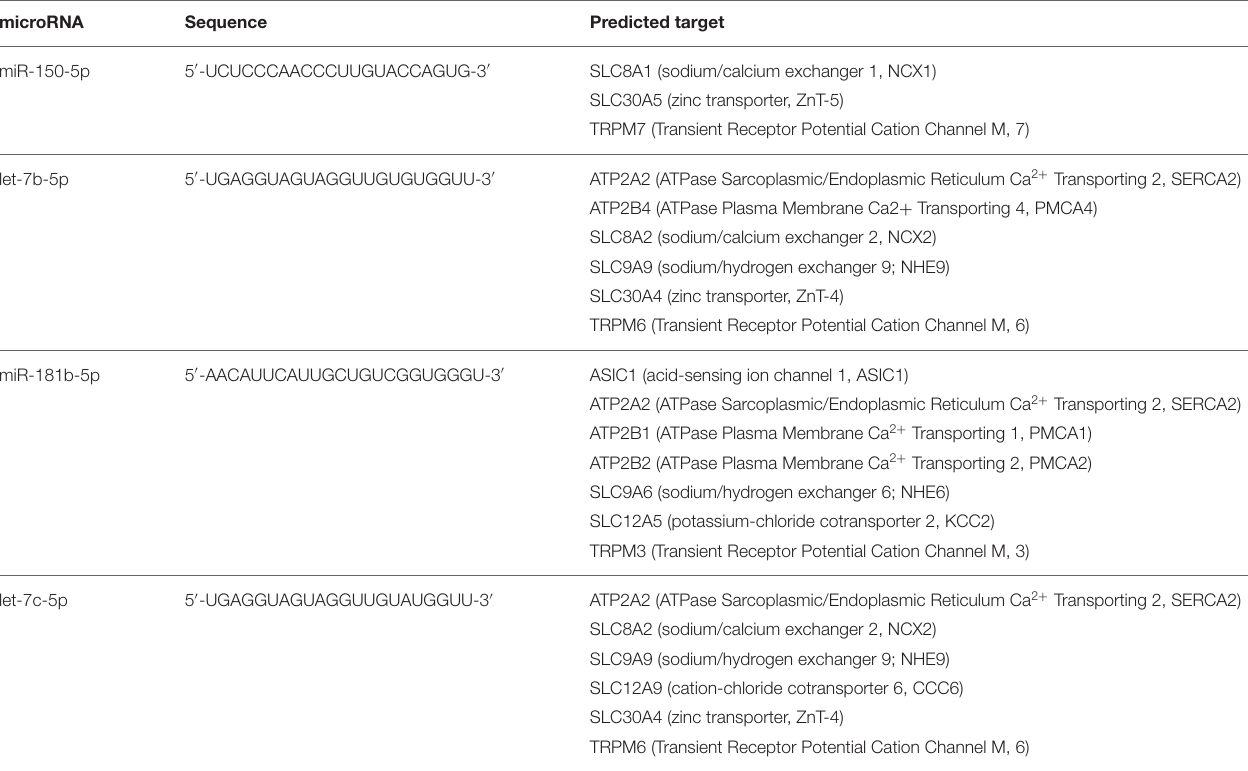
TABLE 2 | List of predicted genes as potential targets of circulating microRNAs modulated by hemorrhagic stroke. microRNA